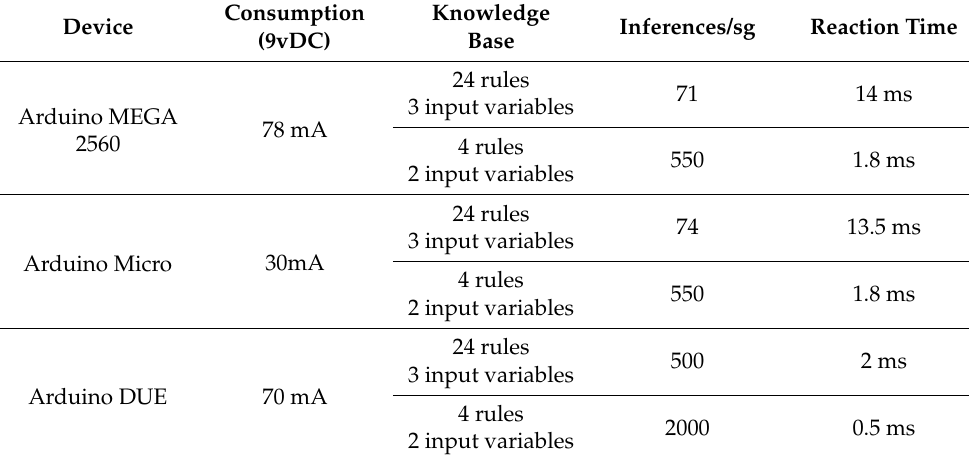
Table 3. Performance of designed FRBS in different